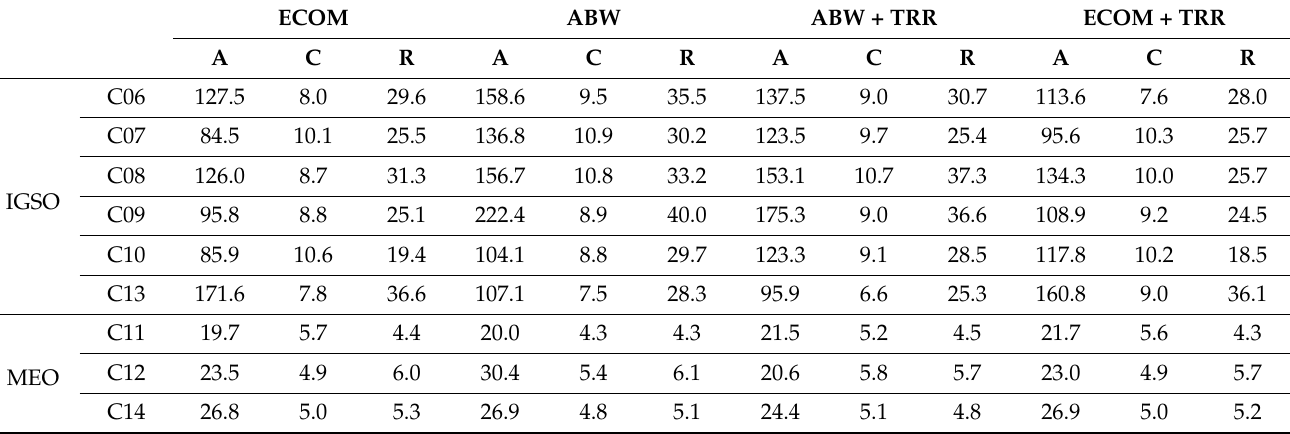
Figure 11. Distribution of the SLR residual for the ECOM + TRR orbit solution with respect to the Sun elongation angle for the BDS-2 C08, C10, C11, and C13 satellites. Table 6. The RMS of the 24-h predicted orbits for the four orbit solutions. A represents the along-track, C the cross-track, and R the radial direction. (unit: